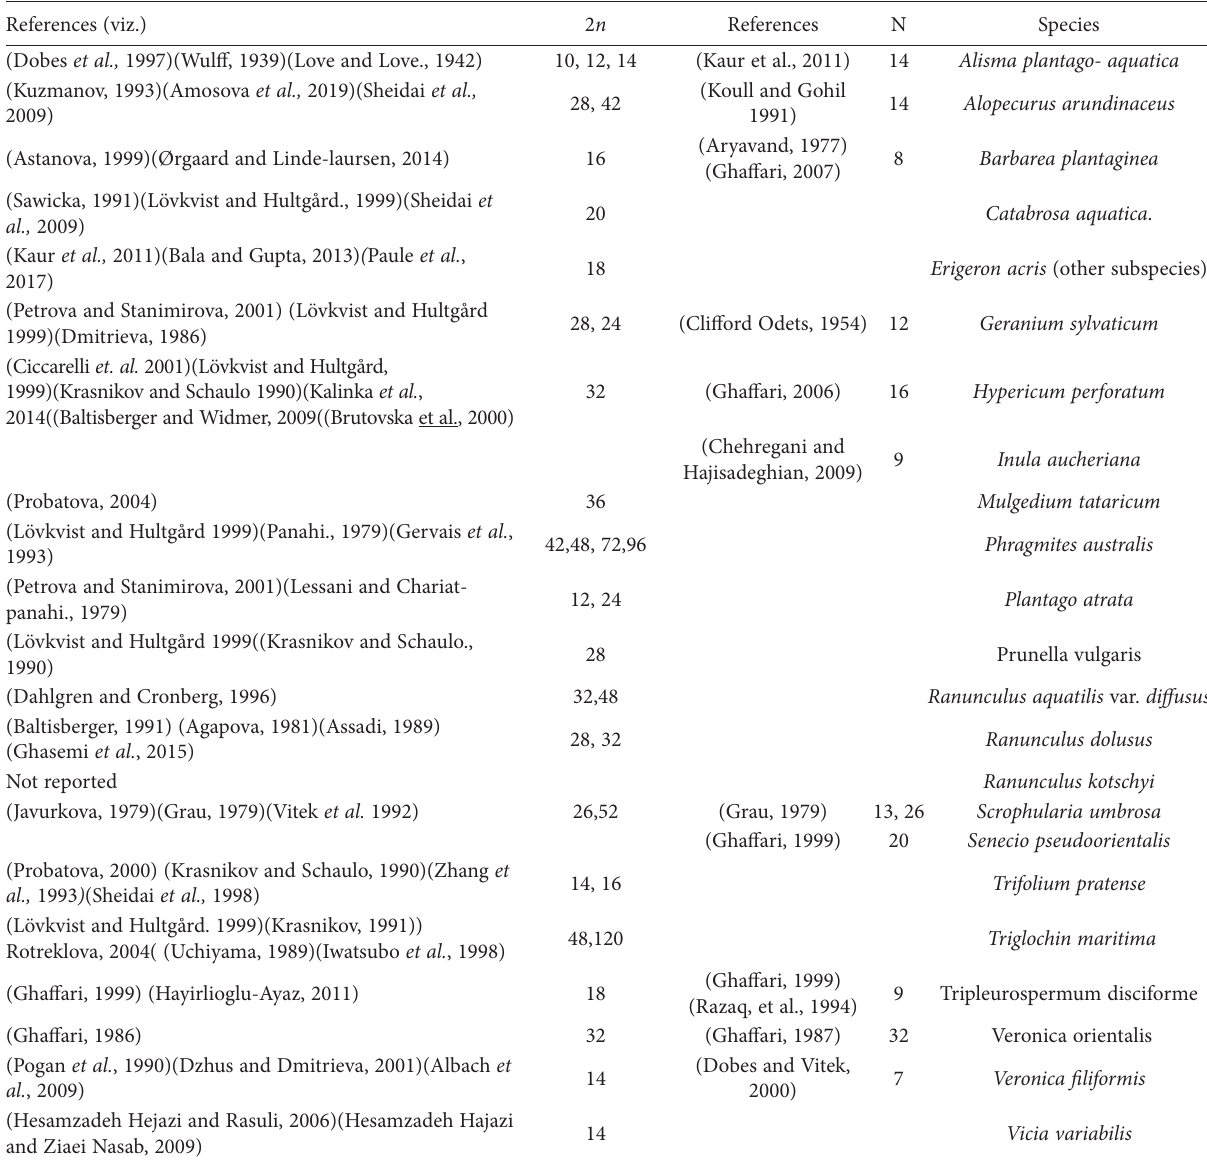
Table 2. Chromosome counts of studied species previously described in the literature. References